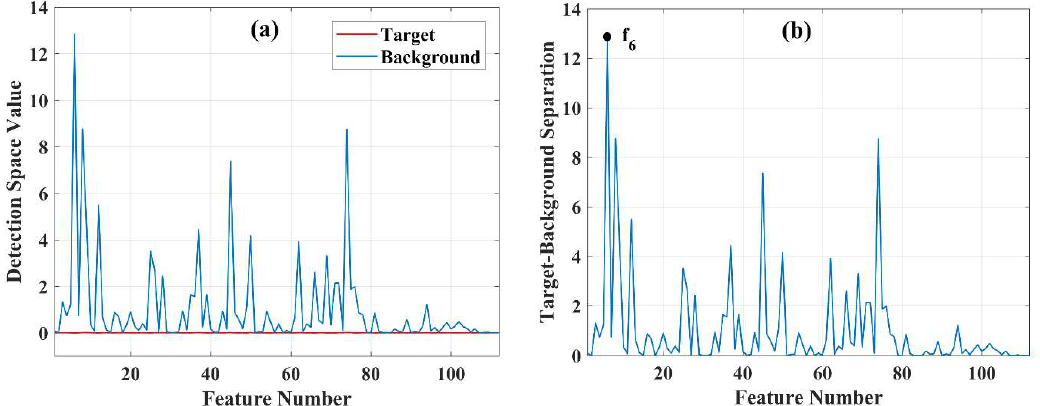
Figure 6. ( a ) The target 𝒕 and background 𝒆 spectra in the detection space (DS). ( b ) The absolute values of the difference between 𝒕 and 𝒆 in all features obtained by the autocorrelation-based feature selection (AFS) method in the full-dimensional DS. (𝒇 (cid:2874) ) is the first optimal feature.